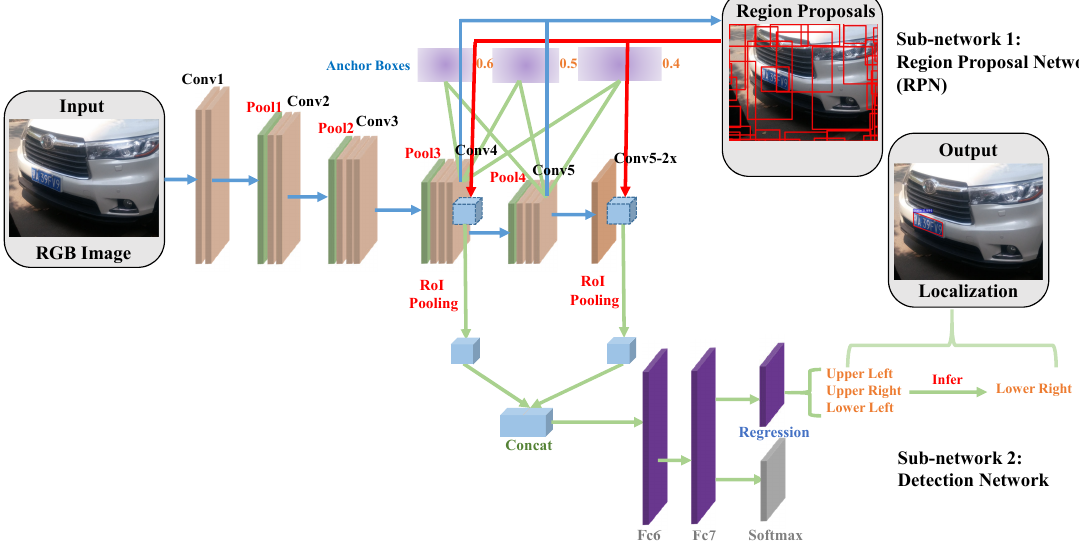
Figure 2. The overall structure of our MOSI-LPD. The backbone framework is Faster R-CNN [27], the classic region-based deep learning network for object detection. To achieve multi-oriented and scale-invariant detection, several vital modifications are proposed. For the RPN sub-network, license plate proposals are generated on both the “Conv5” layer and the “Conv4” layer to combine and produce stronger proposals. The anchor boxes are set based on the priori knowledge regarding inherent shapes of license plates. For the detection sub-network, RoI pooling is conducted on the combined layers of the up-sampled “ Conv5-2x” layer and “Conv4” layer. We estimate three edge points of the license plates by regressing relative positions from horizontal proposals. The fourth edge point is inferred based on the symmetry property to form final bounding parallelograms that tightly enclose the multi-oriented license